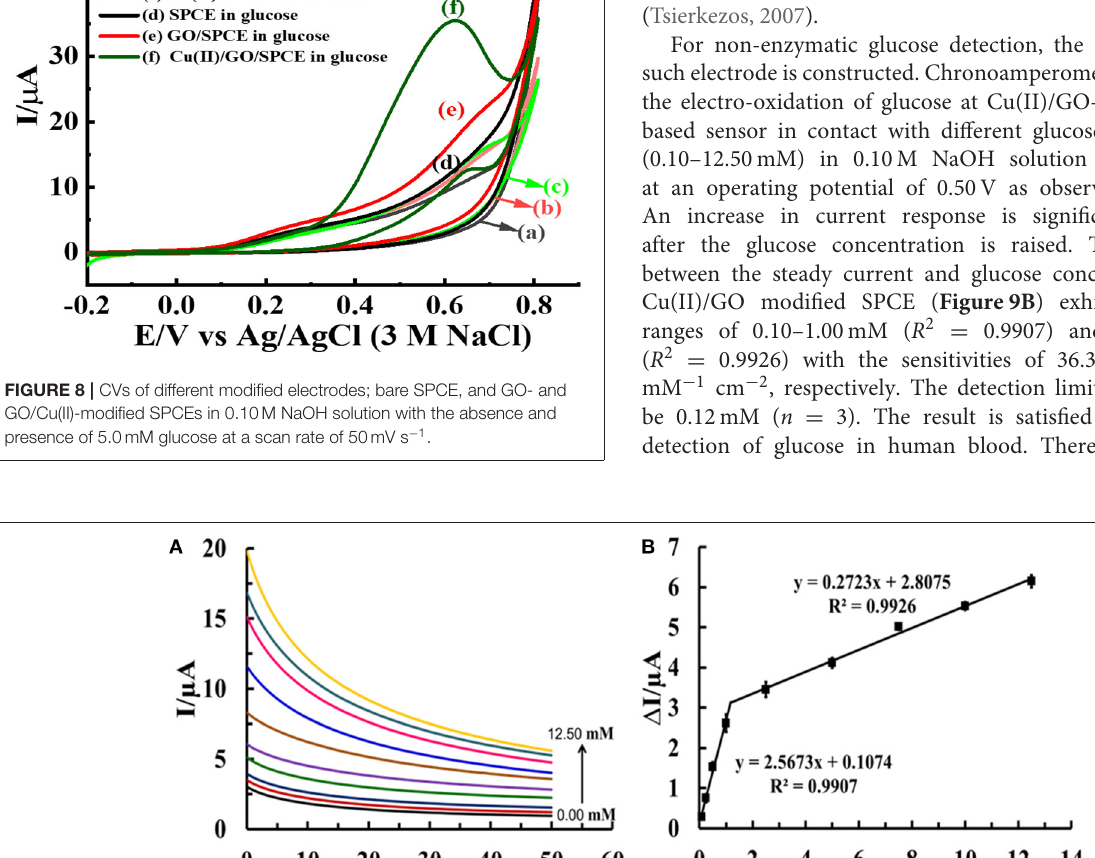
Frontiers in Chemistry |